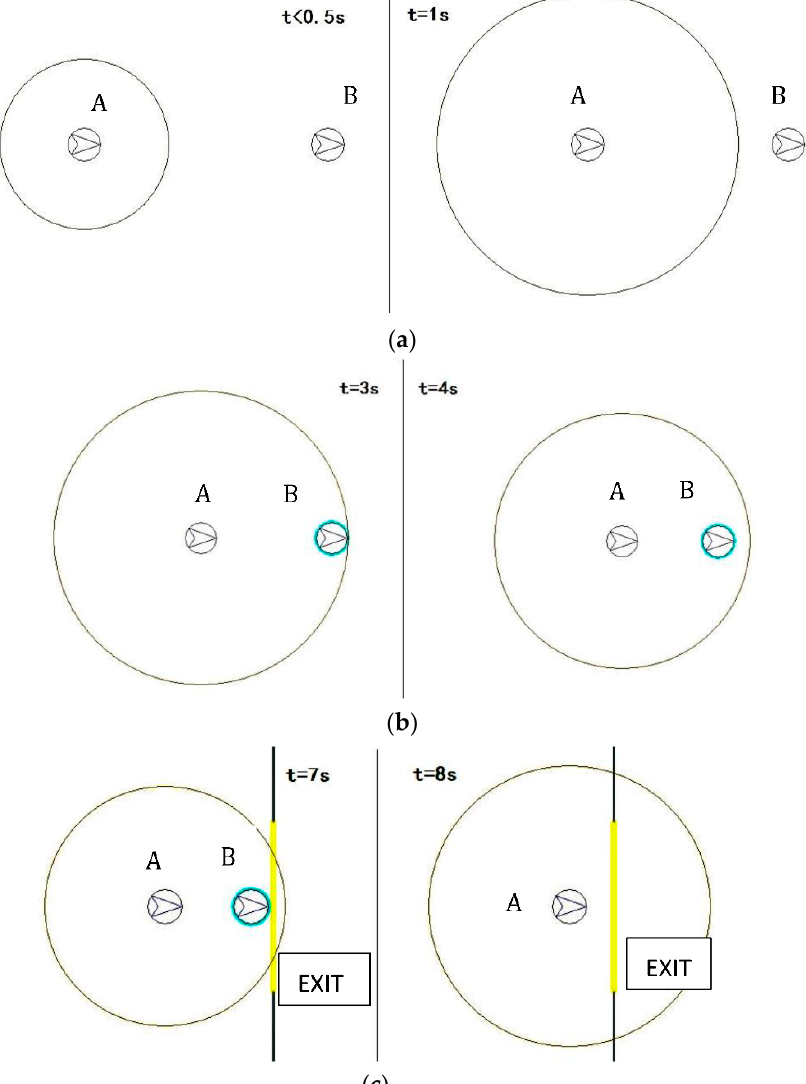
Figure 14. ( a ) Walking state at 0.5 and 1 s. ( b ) Walking state at 3 and 4 s. ( c ) Walking state at 7 and 8 s.